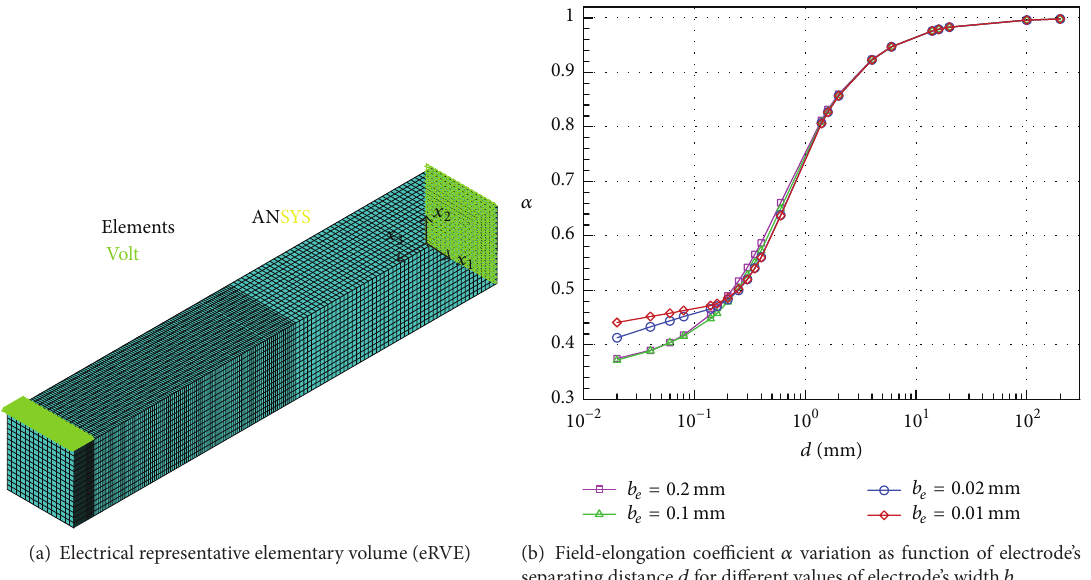
(b) Field-elongation coefficient 𝛼 variation as function of electrode’s separating distance 𝑑 for different values of electrode’s width 𝑏 𝑒 Figure 3: Electric field studies in the homogenized